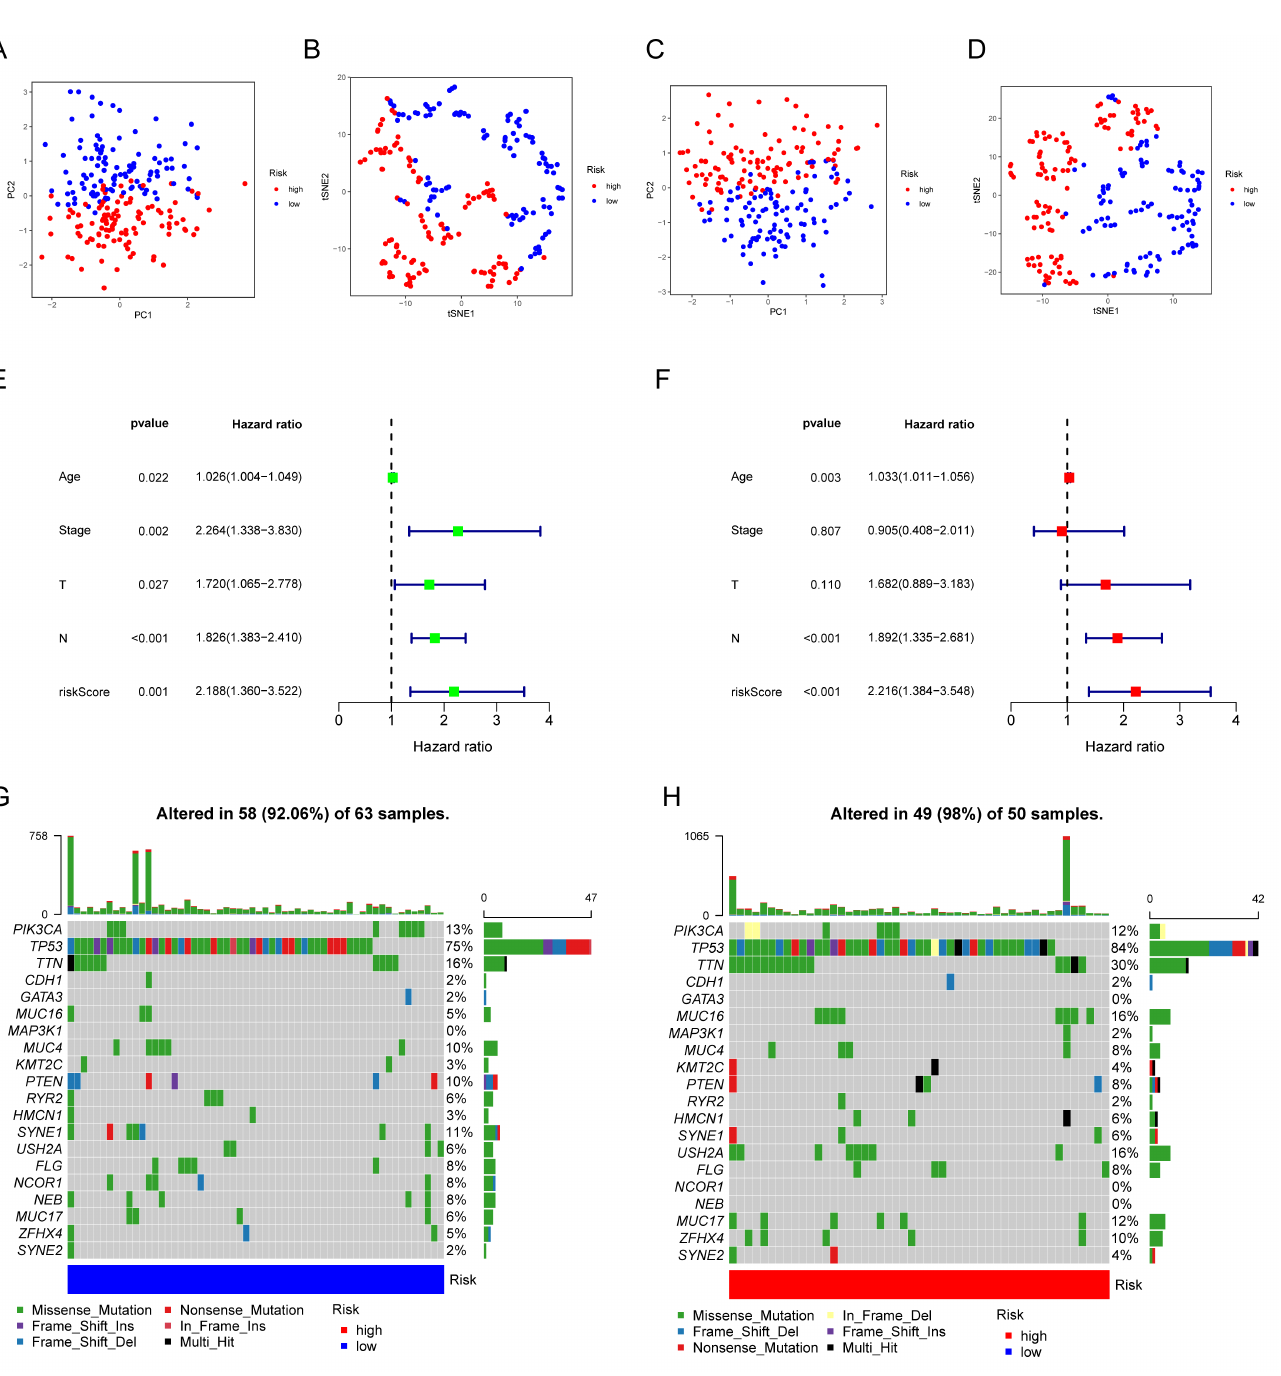
Figure 7. Prognostic value and genomic features in different IRGP subgroups. ( A , B ) PCA analysis and t-SNE analysis of TNBC patients in different IRGP subgroups for the training cohort. ( C , D ) PCA analysis and t-SNE analysis of TNBC patients based on IRGP model for the testing cohort. ( E ) Forest plot for IRGP model score and clinical features in TNBC patients by univariate analyses. ( F ) The multivariate Cox forest plot of IRGP model score and clinical characteristics. ( G , H ) The waterfall plot showing the somatic mutation rate in low IRGP riskscore and high IRGP riskscore. Each column indicates an individual sample. The upper bar plot is the tumor mutation burden for an individual sample. The right histogram generalizes the percentage of each variant type. The number on the right indicates the mutation frequency for each